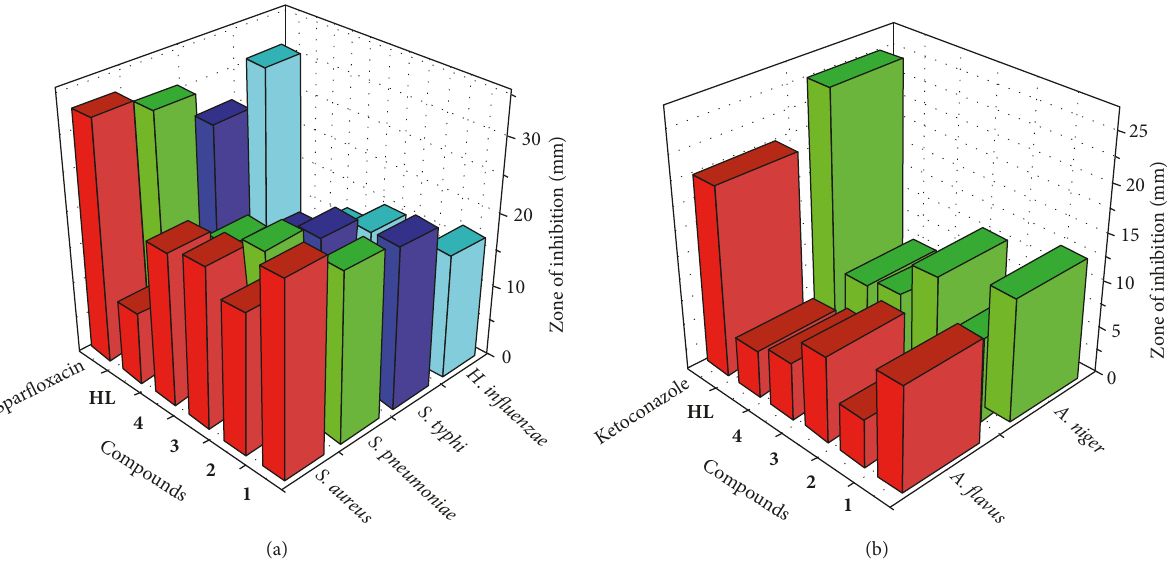
Figure 3: Antimicrobial activity of ligand HL and complexes 1 – 4 : (a) antibacterial; (b) antifungal.